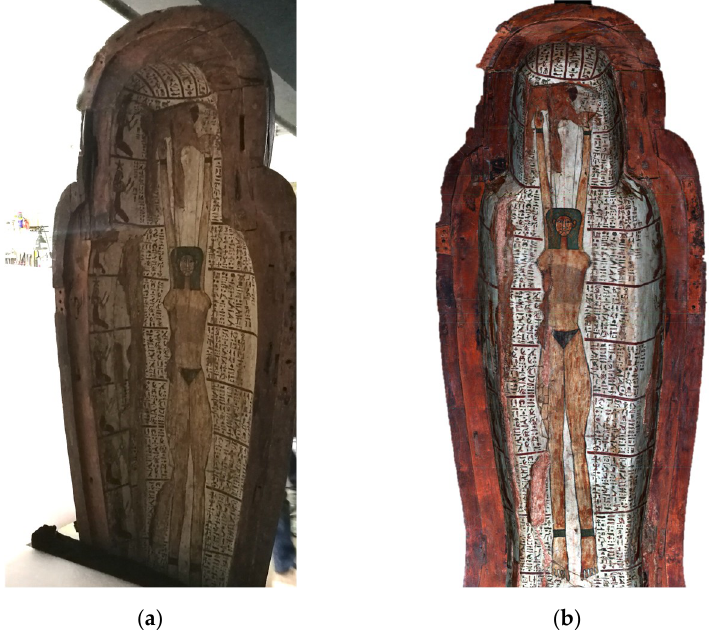
Figure 14. Egyptian sarcophagus: ( a ) photographic image of the inferior part of the anthropomorphous sarcophagus (Photo: S. Ceccarelli); ( b ) part of the 3D model of the ancient wooden artefact achieved with the RGB-ITR system (Elaboration carried out by ENEA team with the custom software itrAnalyzer).